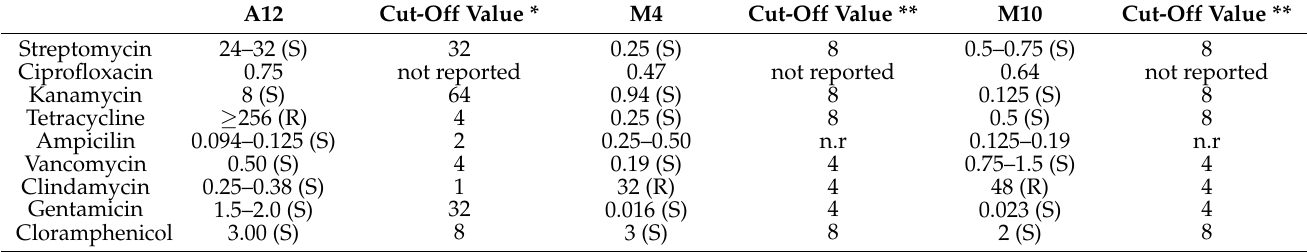
Table 3. Minimal Inhibitory Concentration probiotic Lactococcus lactis A12 (A12), Priestia megaterium M4 (M4), Priestia sp. M10